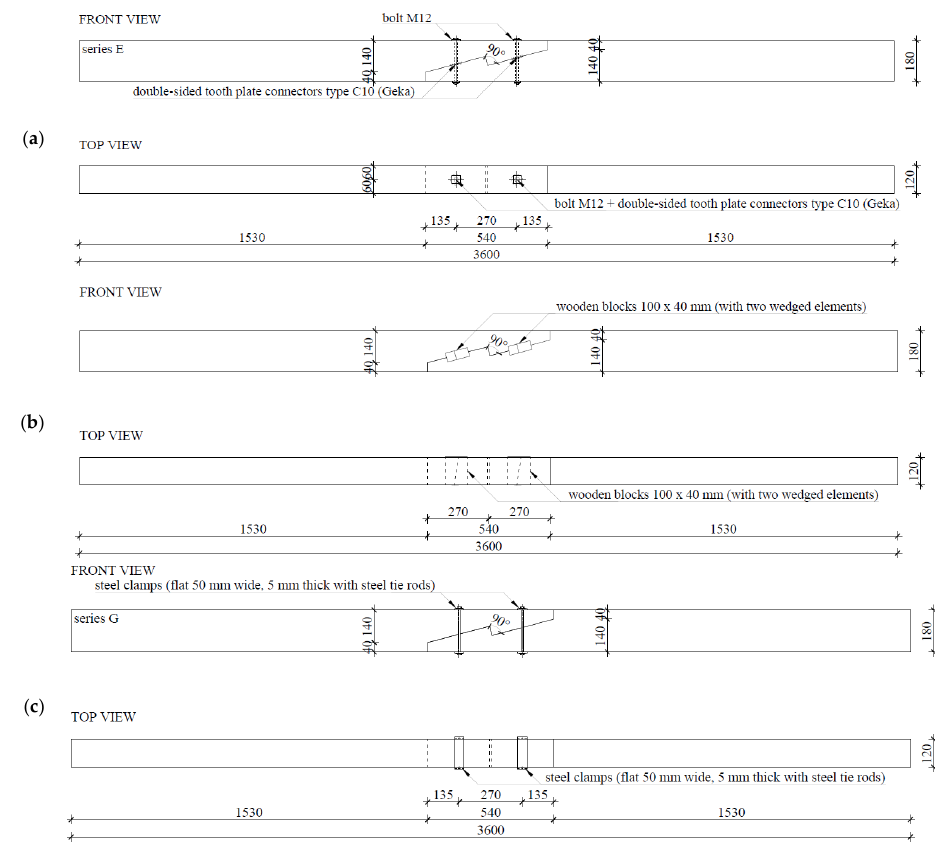
Figure 9. Schemes of the experimental testing models: ( a ) series E—with 2 drawbolts (double-sided tooth plate connectors type C10 + M10 screws), ( b ) series F—with wood inserts (and additional steel clamps), ( c ) series G—with steel